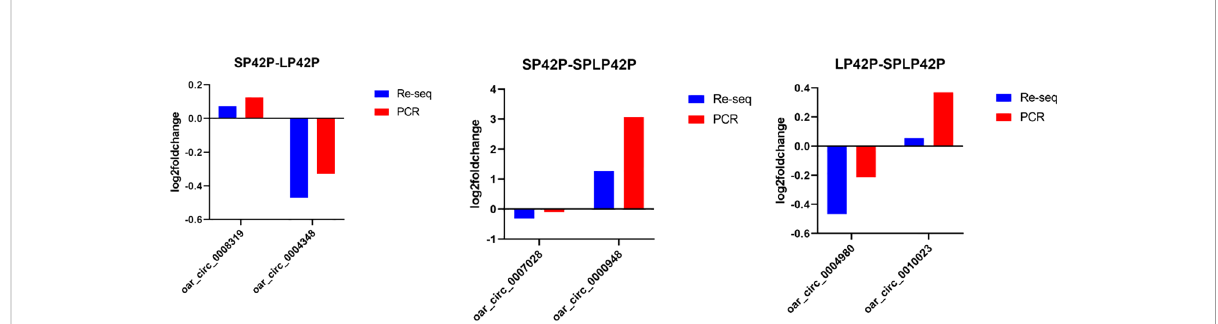
FIGURE 8 Validation of RNA-Sequencing (RNA-seq) data using PCR. RNA-Seq and PCR results of three selected expressed circRNAs in the thyroid gland of Sunite sheep at different photoperiods.